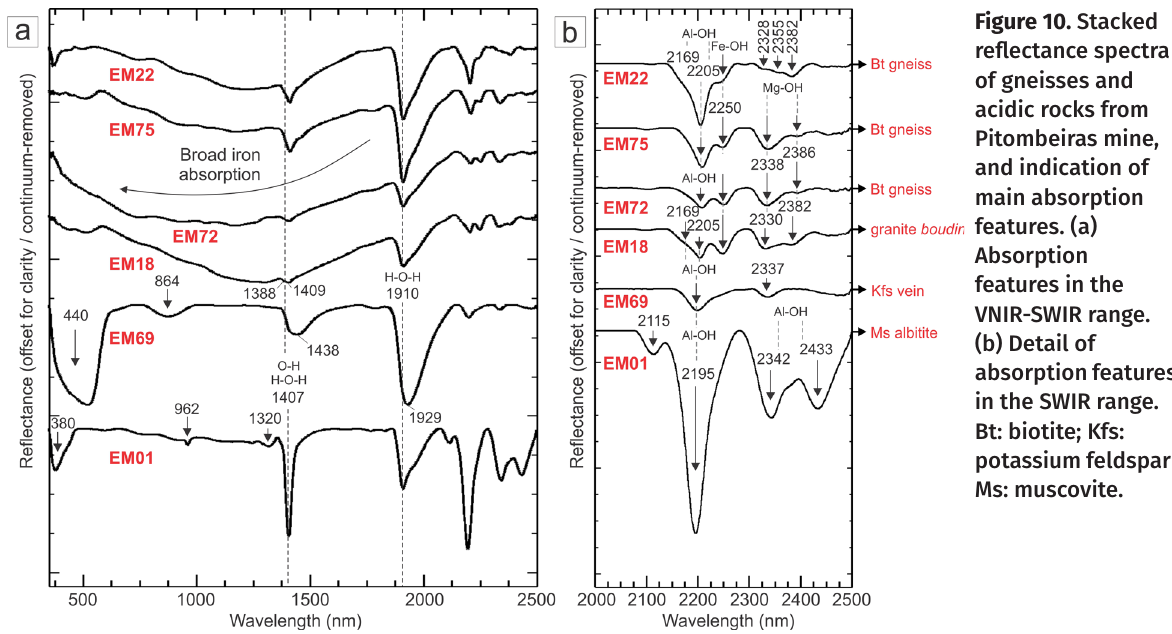
Figure 10. Stacked reflectance spectra of gneisses and acidic rocks from Pitombeiras